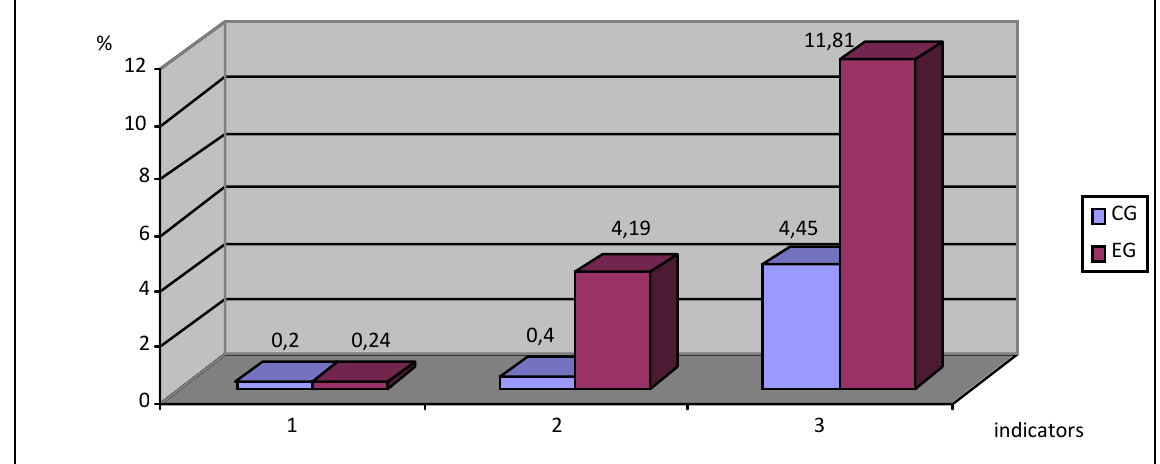
Fig.1. Dynamic of CG and EG girl students’ physical condition indicators in pedagogic experiment (3 rd year). Note: 1 – body length (cm; 2- body mass (kg); 3 – vital capacity of lungs